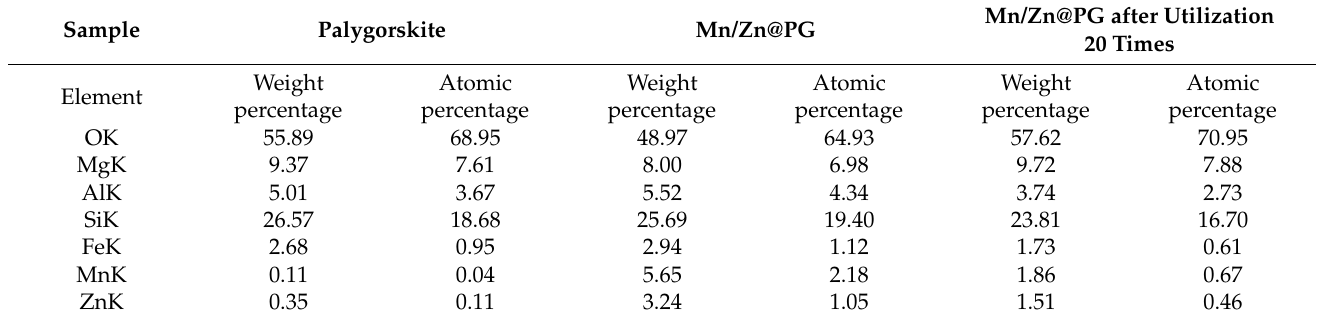
Table 3. EDS characterization of Mn/Zn@PG